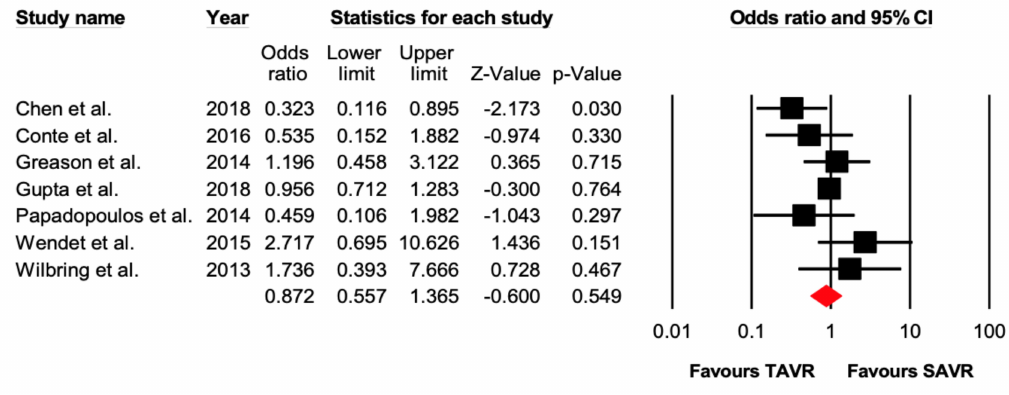
Figure 2. Forest plot comparing the risk of 30-day all-cause mortality between transcatheter versus surgical aortic valve replacement.